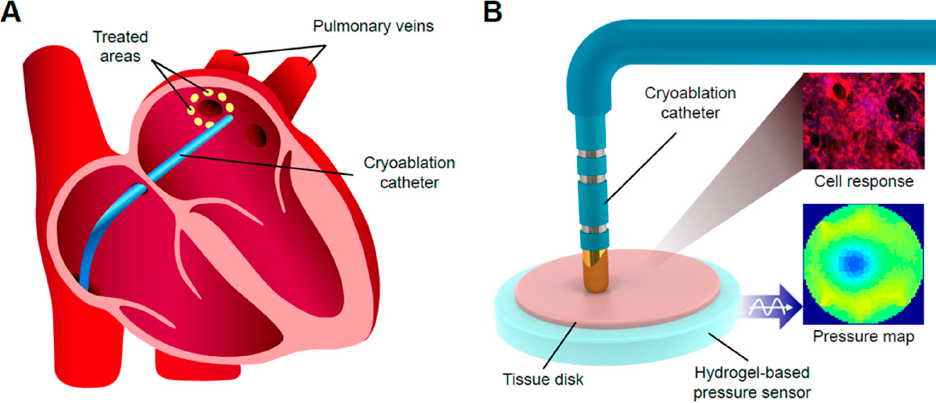
Figure 1. ( A ) Schematic image showing the process of pulmonary vein ablation (two of four veins shown). ( B ) Schematic image showing the bionic myocardial testbed with pressure-sensing capability.